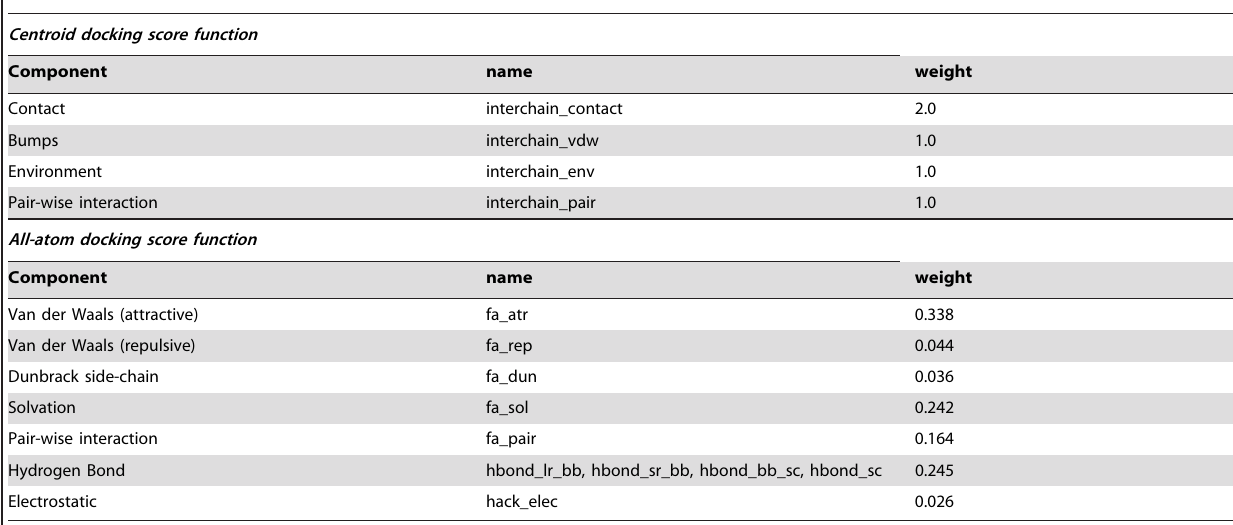
Table 1. RosettaDock scoring components and